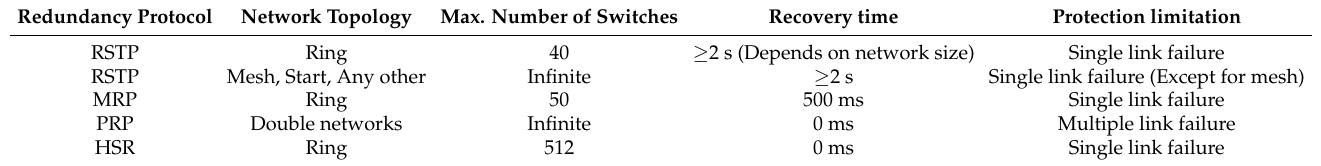
Table 1. Redundancy protocols features